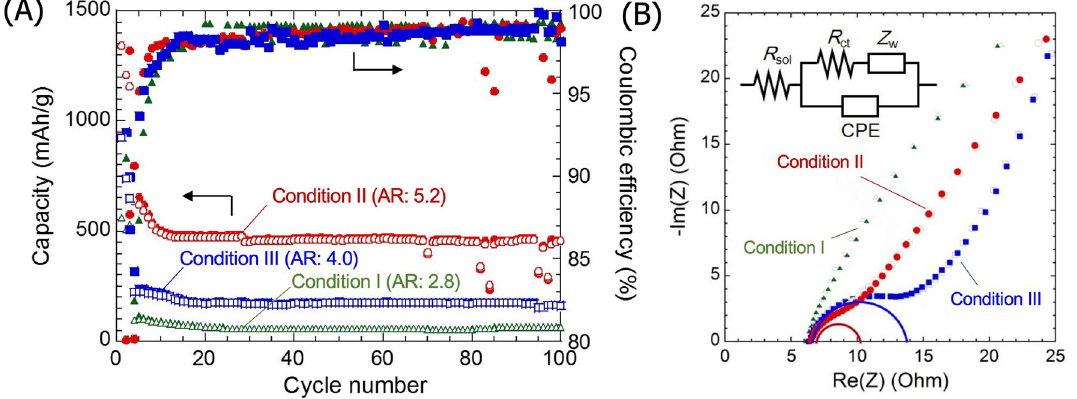
Figure 4. ( A ) Capacity and coulombic efficiency as a function of cycle number for cells prepared with Si nanorods of differing aspect ratio as the anode material. ( B ) Cole–cole plots for symmetric cells with different Si nanorods